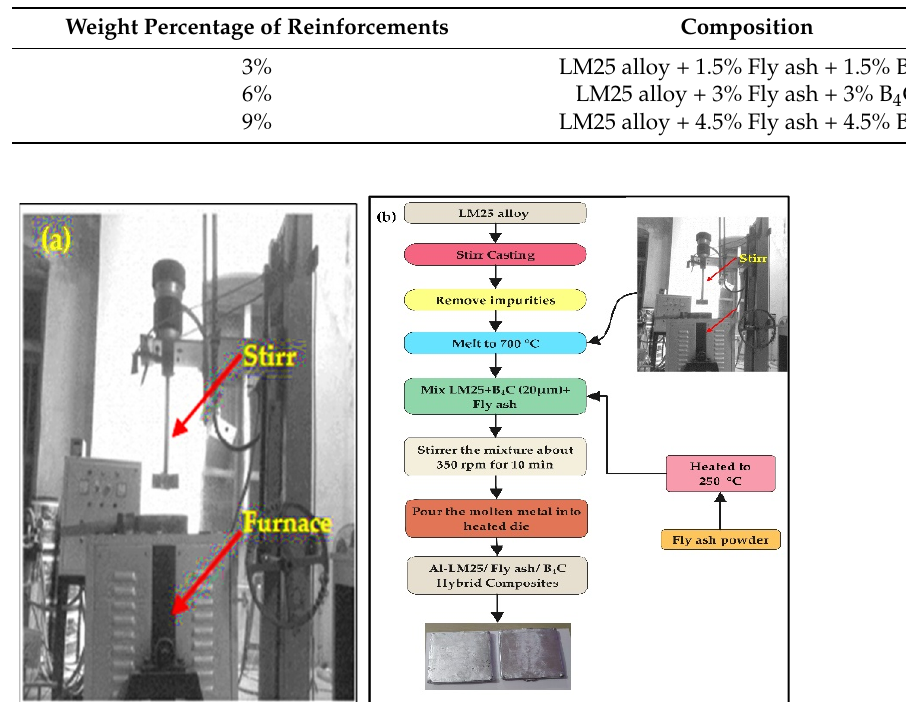
Figure 1. ( a ) Stir casting process setup. ( b ) Flow chart of Al-LM25/fly ash/B4C hybrid composites. Table 3. Weight compositions of hybrid composites.